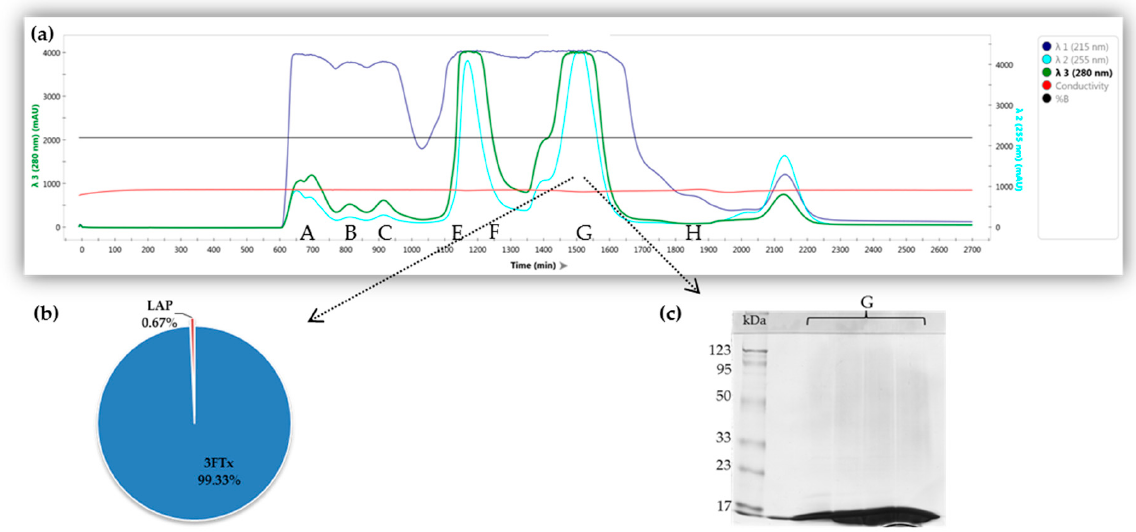
Figure 1. Crude venom size exclusion chromatography (SEC) separation and protein identification schemes in Fraction G: ( a ) SEC chromatogram obtained for the separation of Naja ashei venom using Sephadex G75 Superfine. The fractions collected during the experiment were marked by labels (A–H) below the peaks; ( b ) Pie chart presents the results of the quantitative MS analysis for the G fraction; 3FTx (three-finger toxins); LAP (low abundant proteins)—proteins whose total percentage share did not exceed 1% were included in the LAP group. The complete list of proteins with its quantitative data is provided in the Supplementary Materials; ( c ) SDS-PAGE of the collected chromatographic samples belonging to Fraction G.